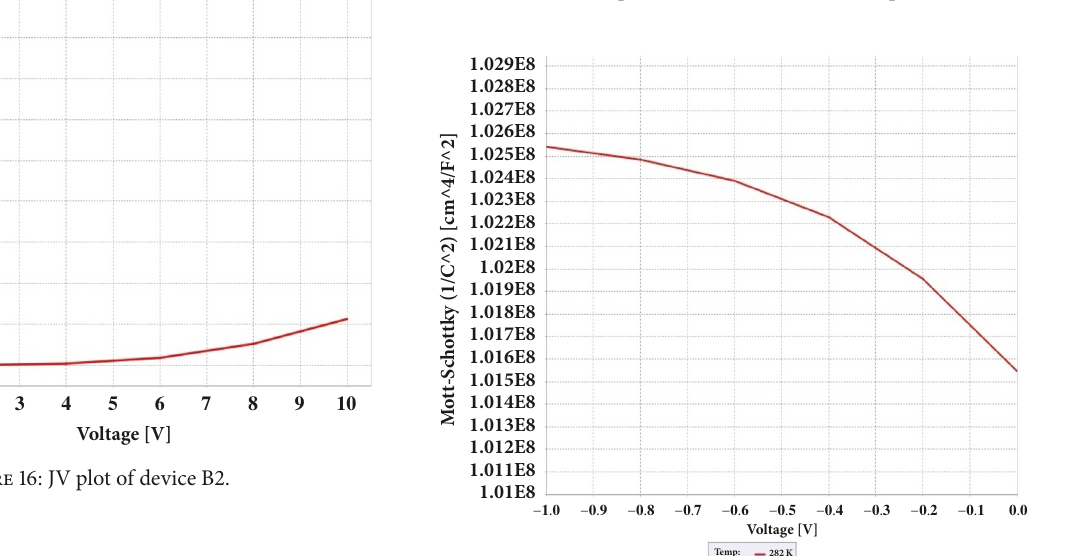
Figure 17: JV plot of device R at various temperatures.